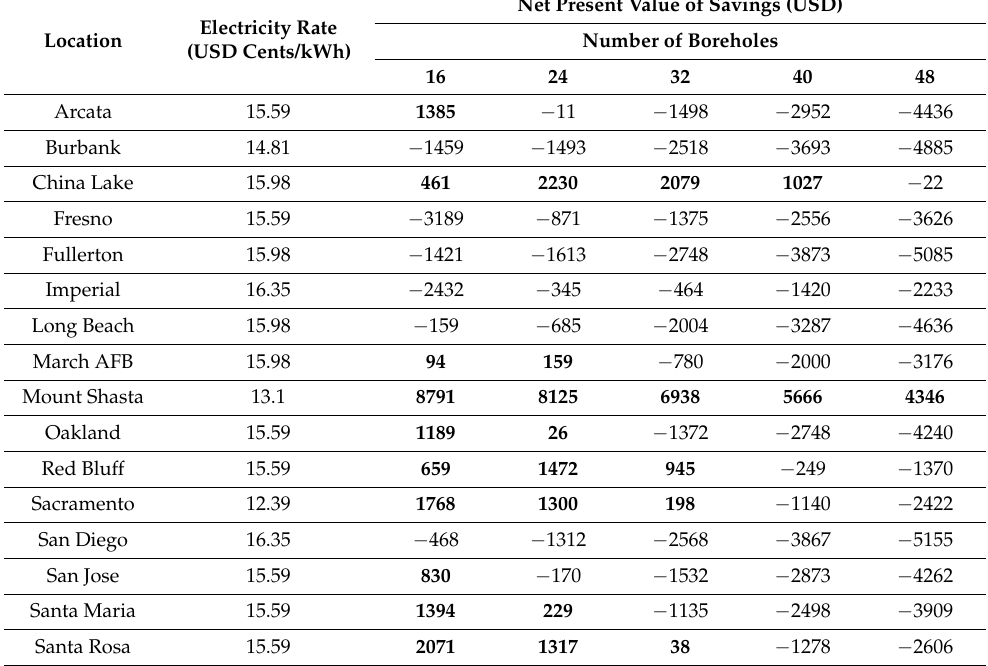
Table 8. NPV analysis results for S-GSHP systems with 6.7 m (22 ft) boreholes for 16 California locations.